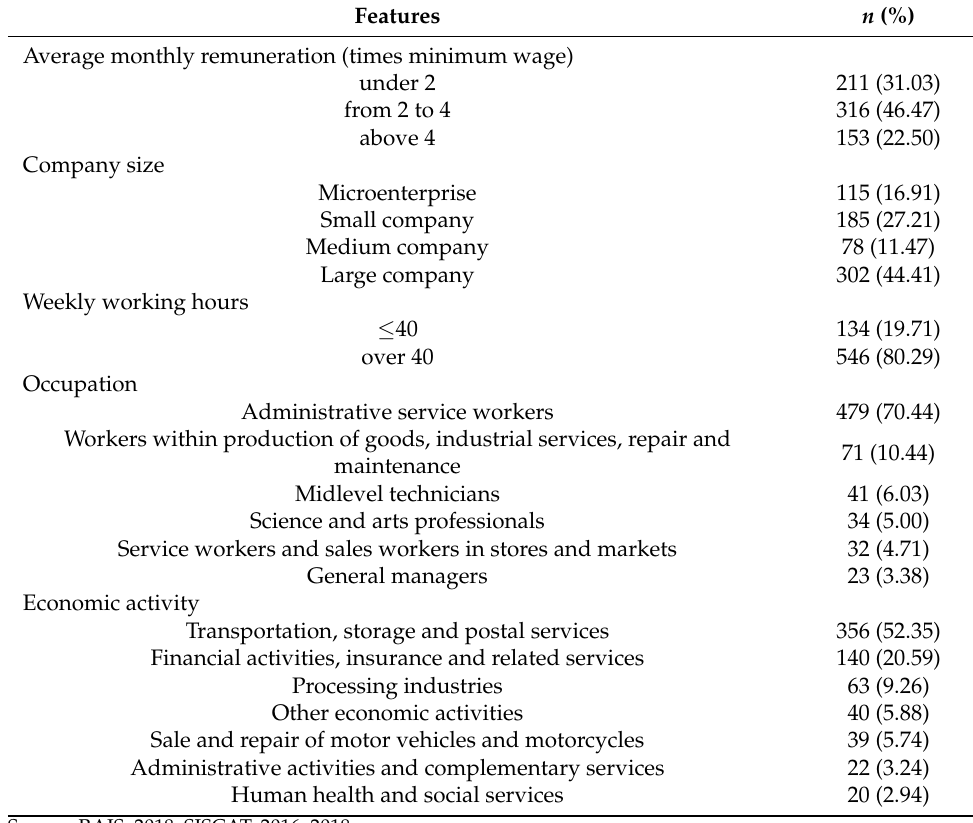
Table 2. Occupational characteristics of workers with disabilities due to WRMDs who had undergone rehabilitation through Social Security and then returned to the formal employment market. Brazil, 2014–2018 ( n = 680). Features n